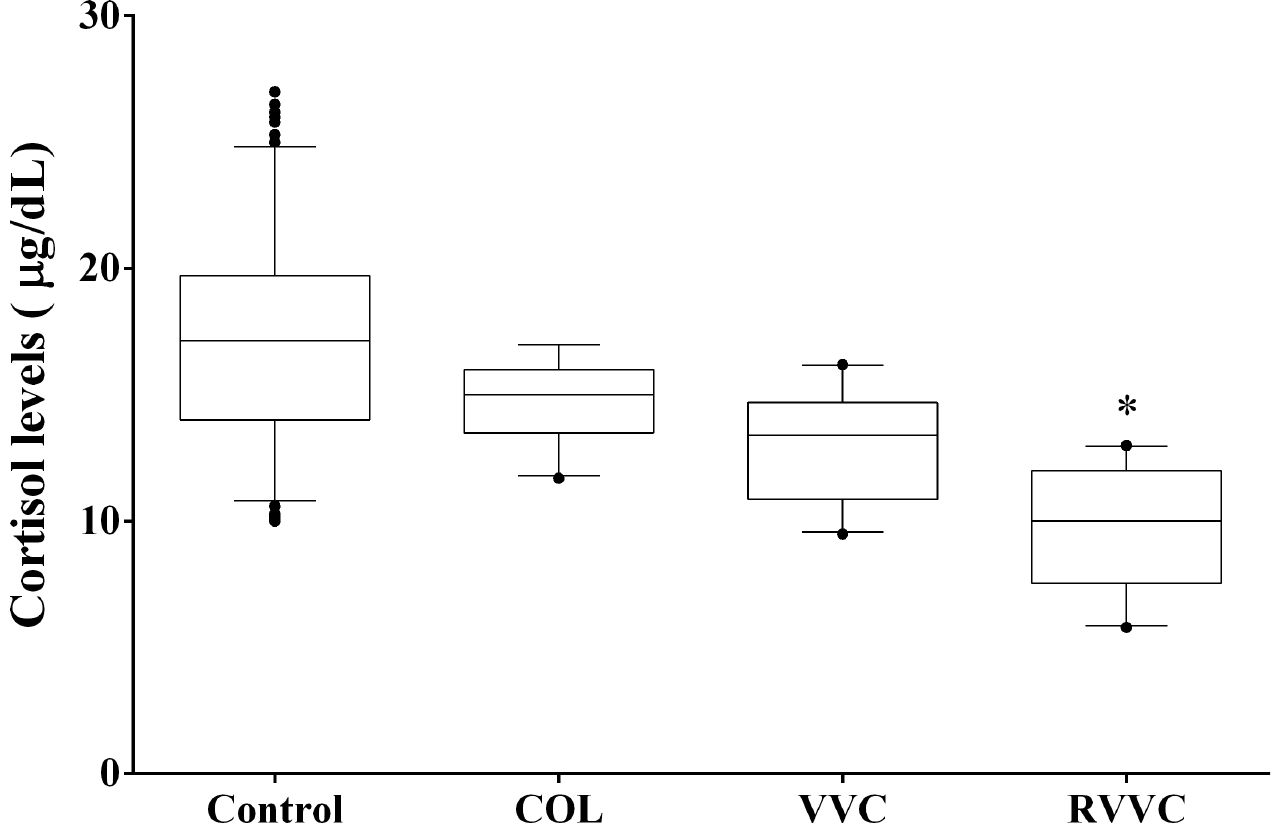
Fig 3. Morning cortisol levels according to the women clinical profiles. Median values of each group (Control, COL, VVC and RVVC) were calculated and compared using a Kruskal-Wallis and subsequently Dunn ’ s post-hoc test with all pairwise comparisons identified which groups differed. Box plots show the median, 25th and 75th percentiles of the cortisol levels. Whiskers extend to the 5th and 95th percentiles; filled circles represent outliers. Cortisol levels were determined in triplicate employing chemiluminescent microparticle immunoassay in the Architect-i1000SR Immunoassay Analyzer (Abbott, Illinois, USA). * p = 0.001, shows that women of the RVVC group has a lower mean cortisol level than the control and COL